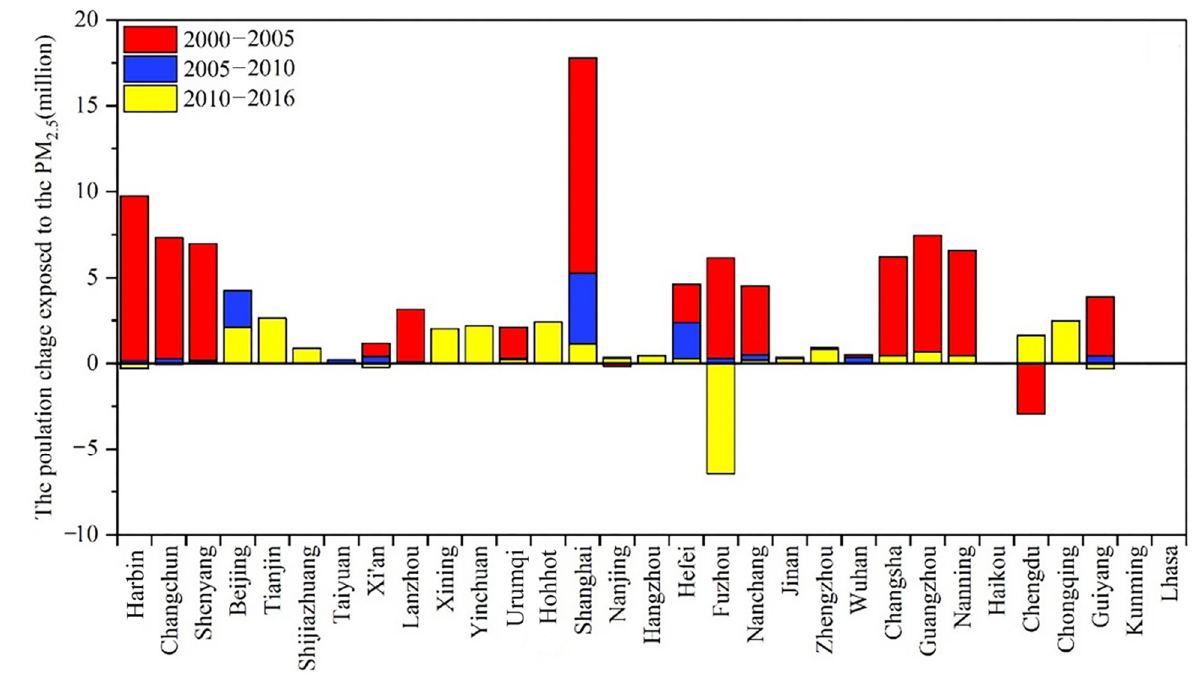
Figure A2. The change of population in three terms of 2000–2005, 2005–2010 and 2010–2016.